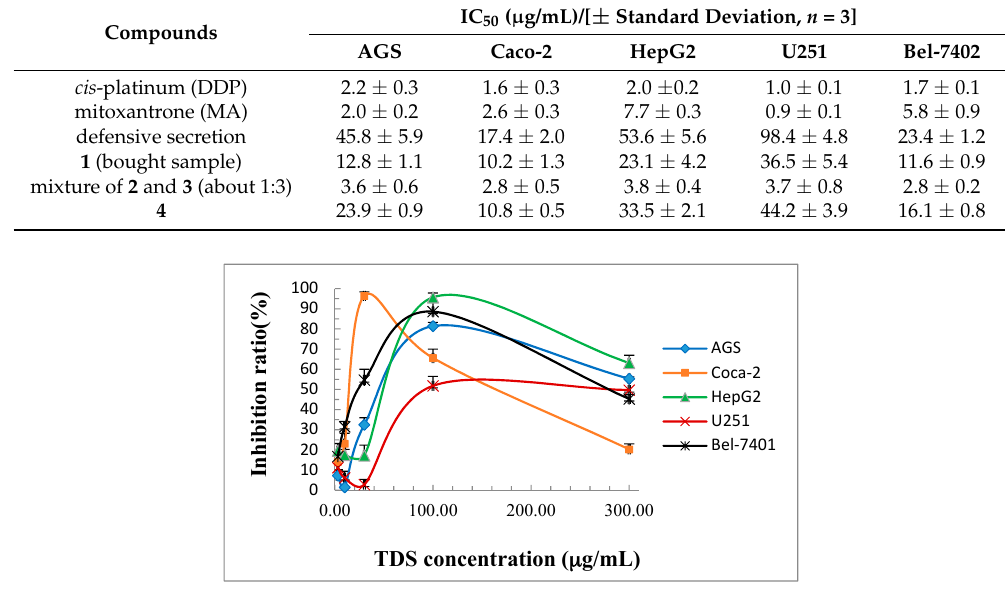
Figure 2. Inhibitory rate curves of TDS on tumor cell lines.